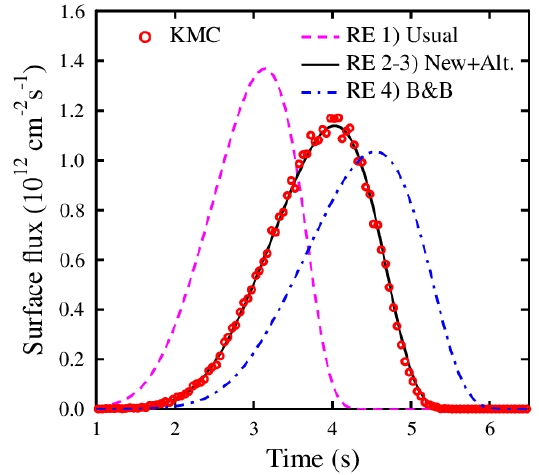
Figure 3. The front surface defect flux comparison between the kinetic Monte Carlo (KMC) and rate theory equations (RE) simulations using different sink strength theories (see text and Table